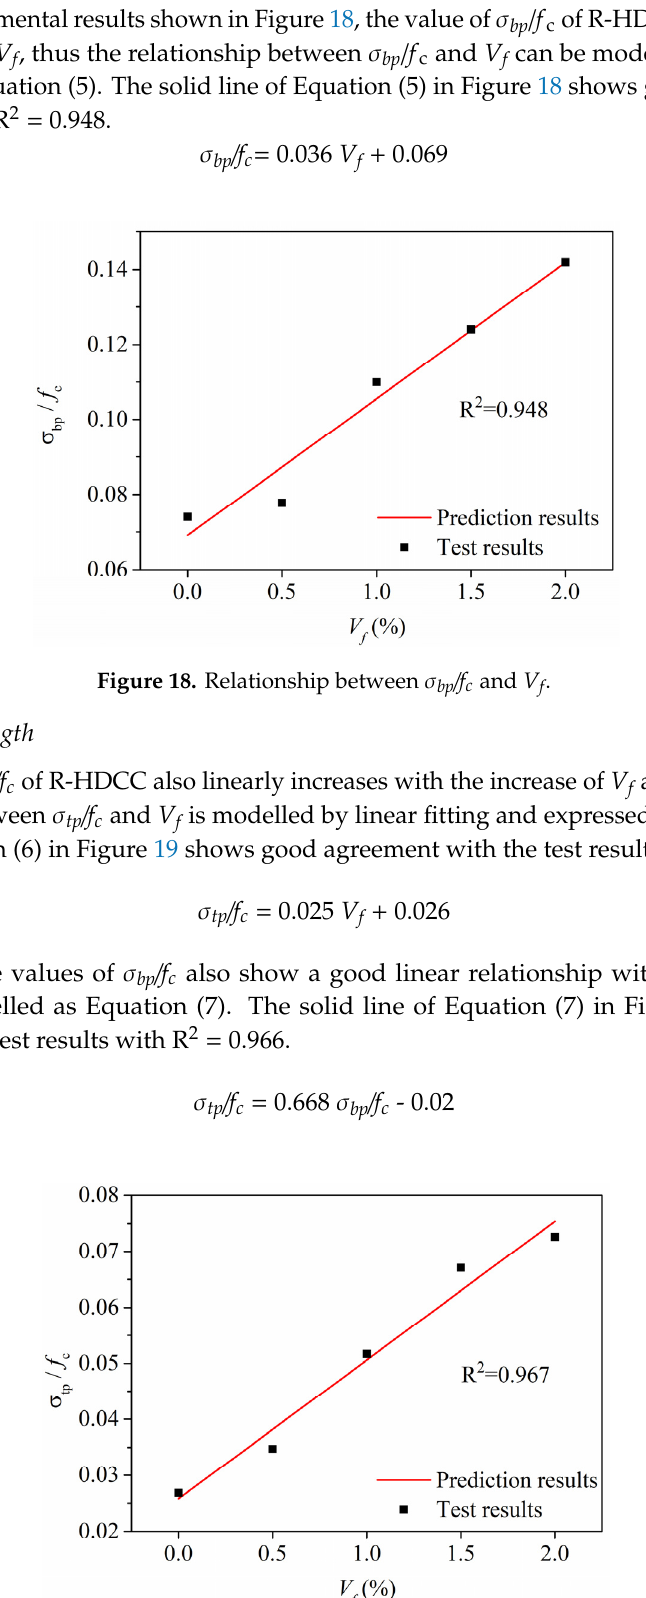
Figure 19. Relationship between σ tp /f c and V f .